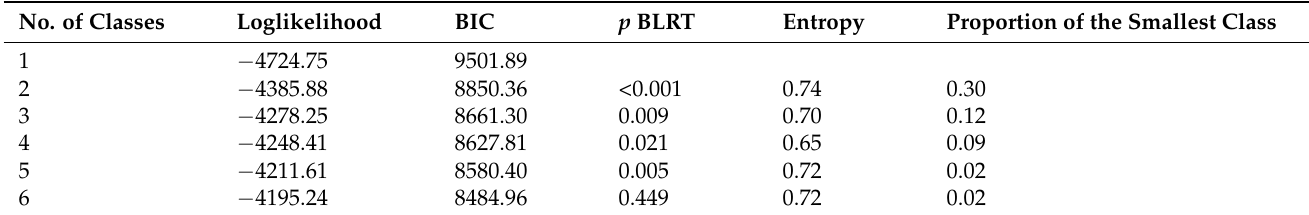
Table 4. Comparison of Latent Class Growth Curve Models.